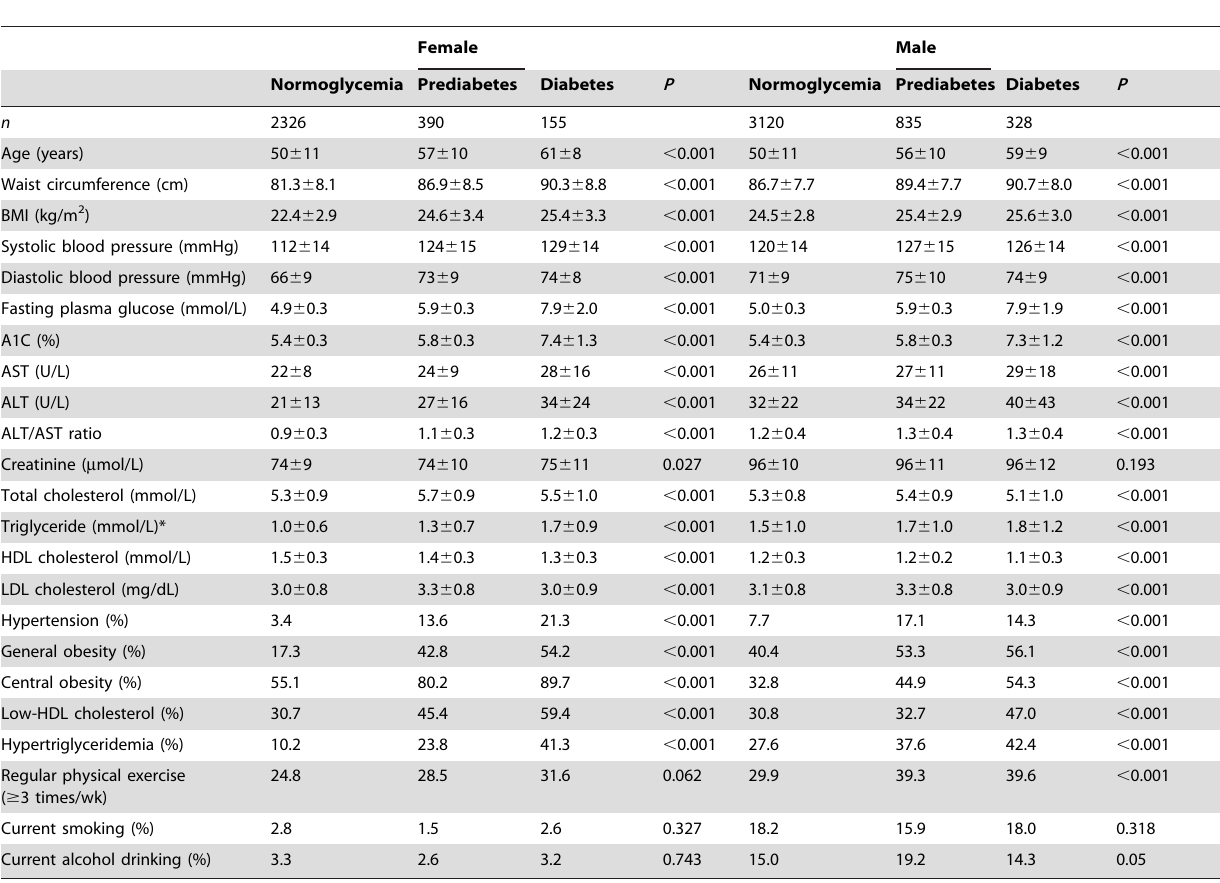
Table 1. Clinical characteristics of study subjects with normoglycemia, prediabetes, and diabetes stratified by gender.